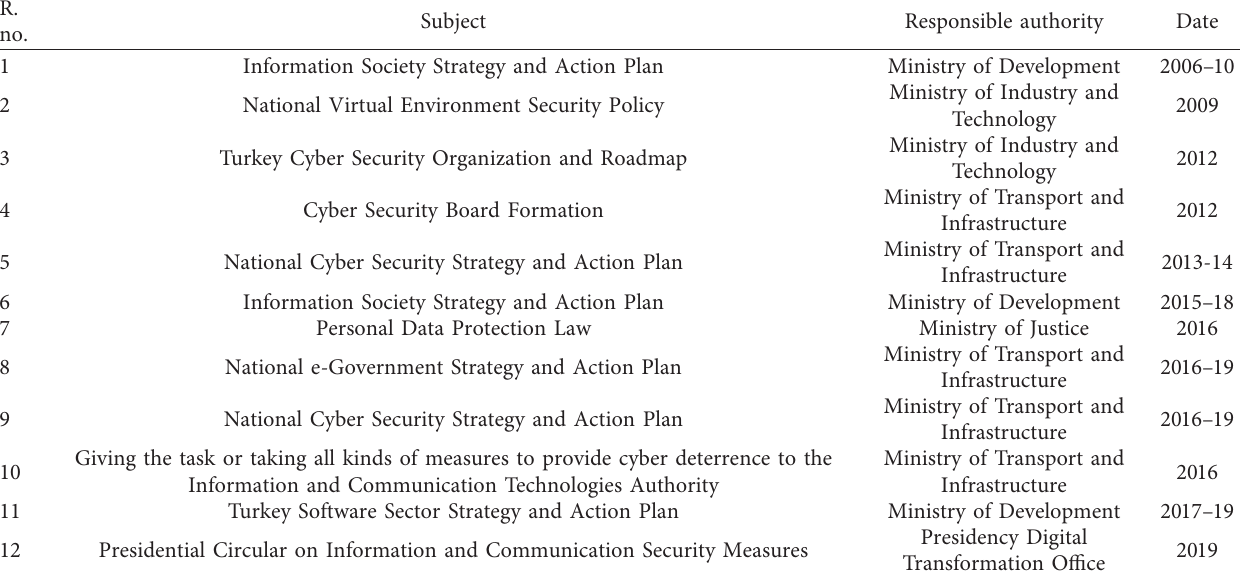
Table 2: Turkey’s important cyber security strategy documents and